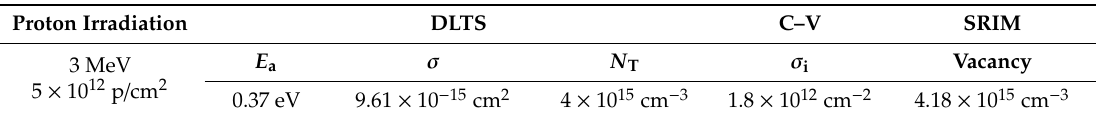
Figure 5. In vacancies and P vacancies in InP / InGaAs heterostructures with 3 MeV proton irradiation at the fluence of 5 × 10 12 p / cm 2 . Table 1. The traps in InP / InGaAs heterostructures obtained by DLTS measurement, C–V analysis, and SRIM simulation.